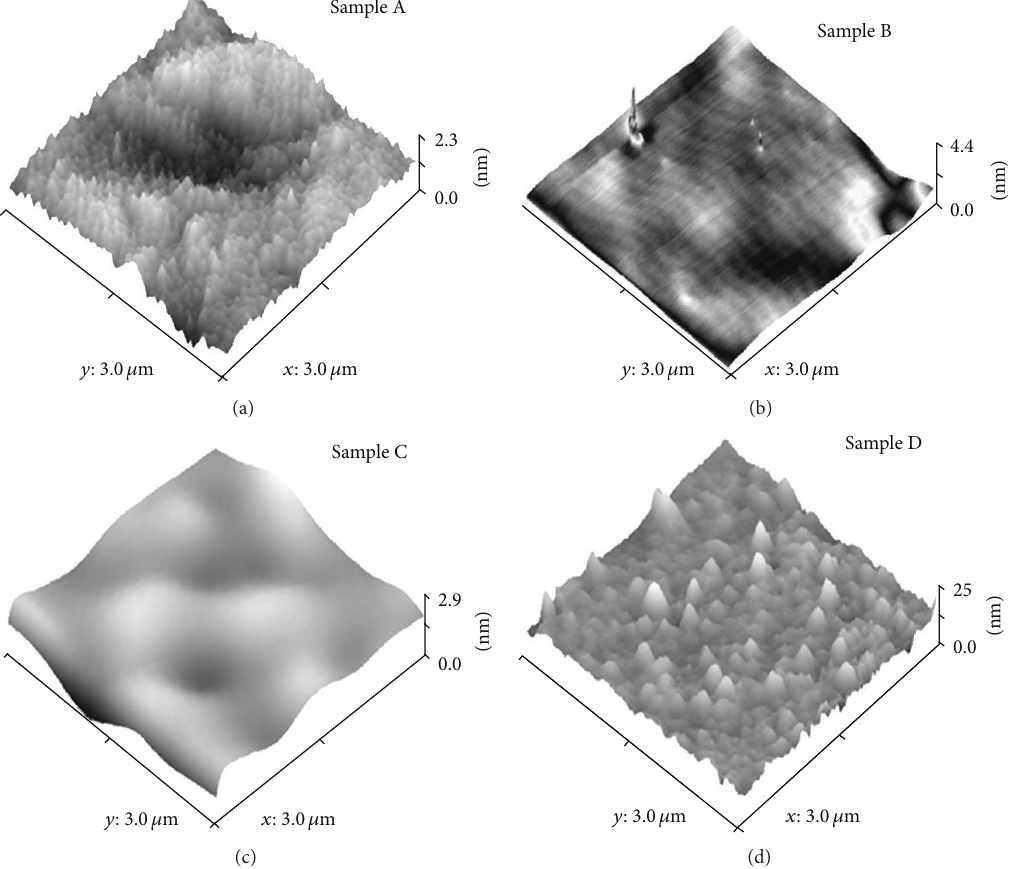
Figure 2: 3×3 𝜇 m 2 AFM image for as-grown sample A (a) with RMS of 0.352 nm, at 800 ∘ C-N 2 -activated sample B (b) with RMS of 0.225 nm, 850 ∘ C-N 2 -activated sample C (c) with RMS of 0.299 nm, and 900 ∘ C-N 2 -activated sample D (d) with RMS of 2.21 nm for 5 min.